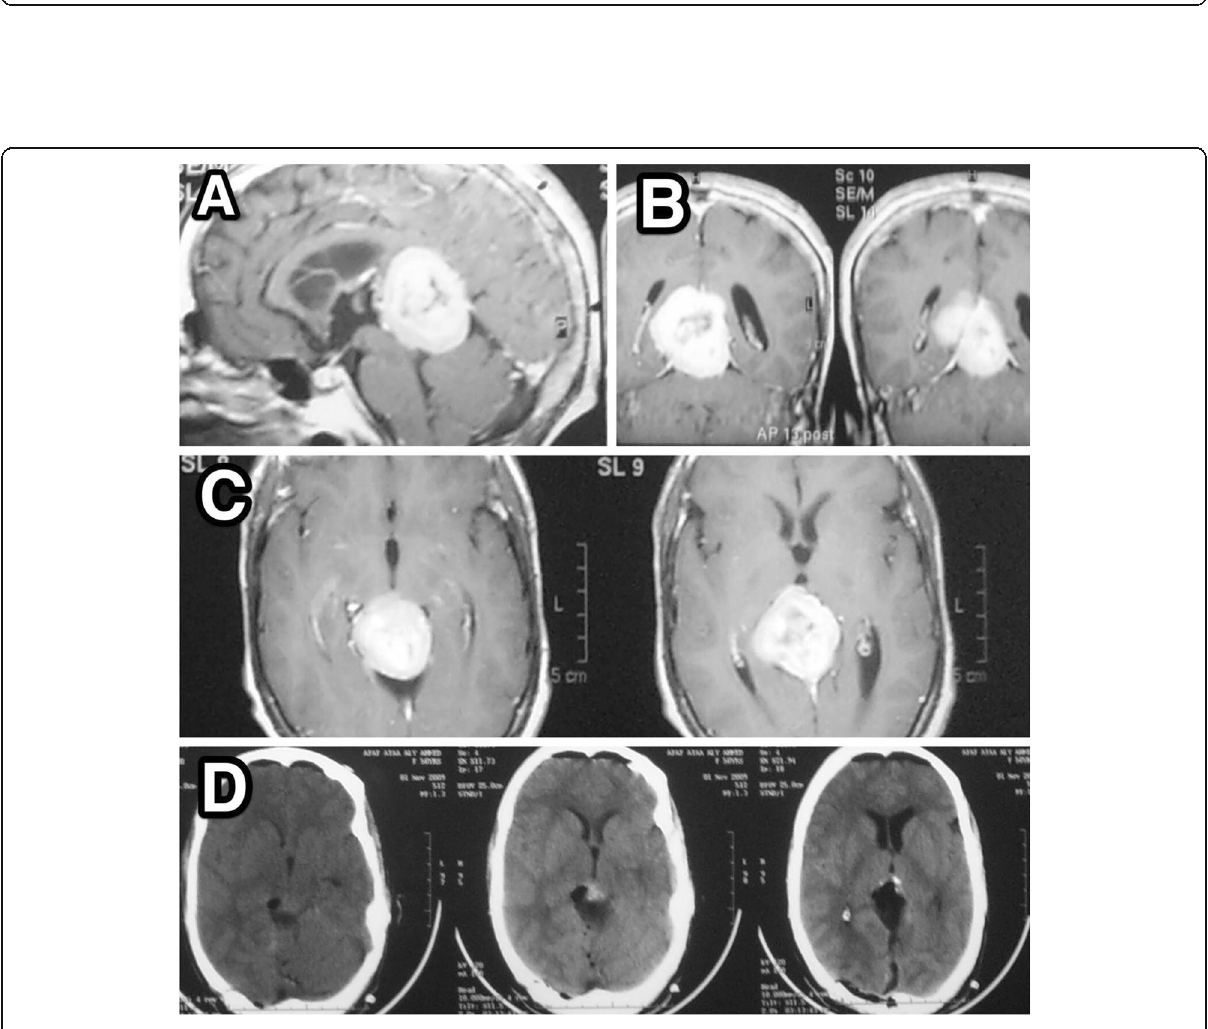
Fig. 3 Falcotentorial meningioma operated through posterior interhemispheric approach in ¾ prone position. The right side was dependent. A -